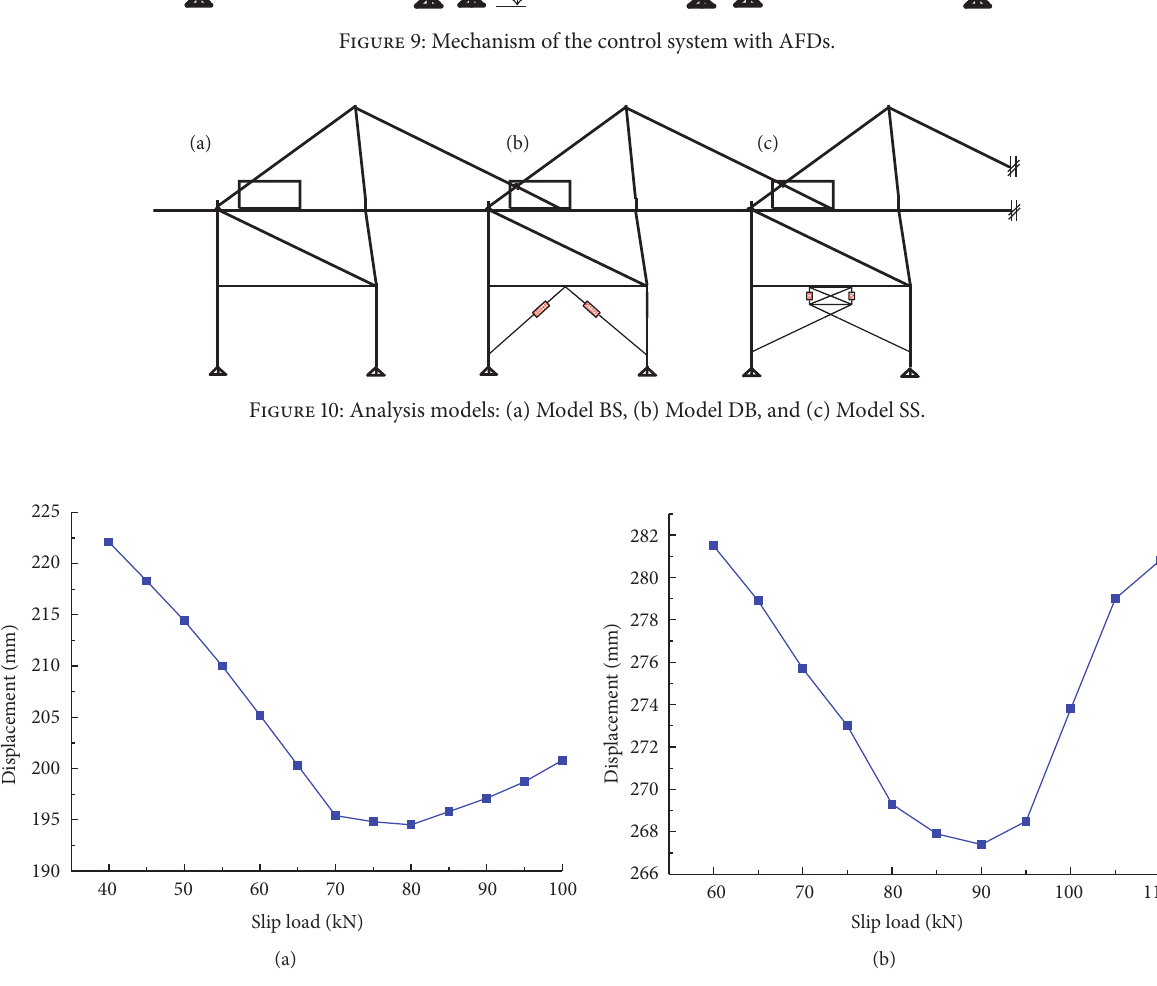
Figure 11: Maximum displacement at the top of the crane versus slip load: (a) PGA = 0.4 g and (b) PGA = 0.62 g.